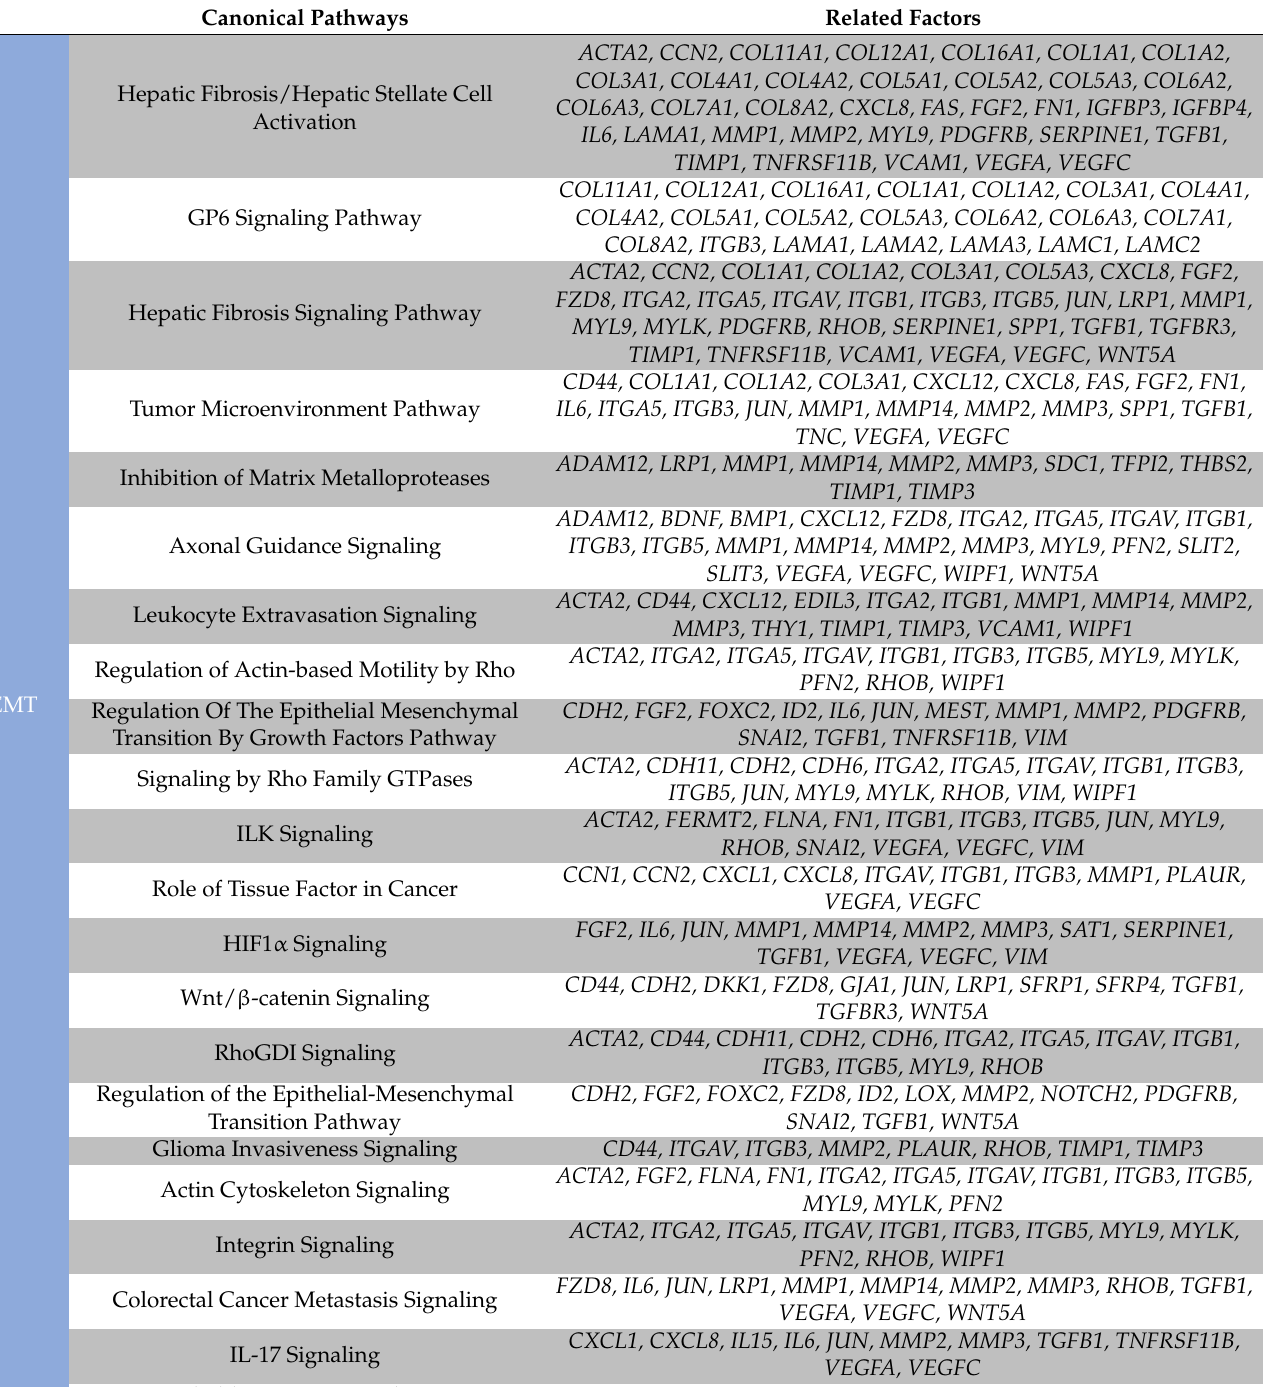
Table 2. EMT and MET hallmarks involved in the canonical pathway. Molecules participated in EMT or MET processes, and specific canonical pathways were found to cause a possible molecular